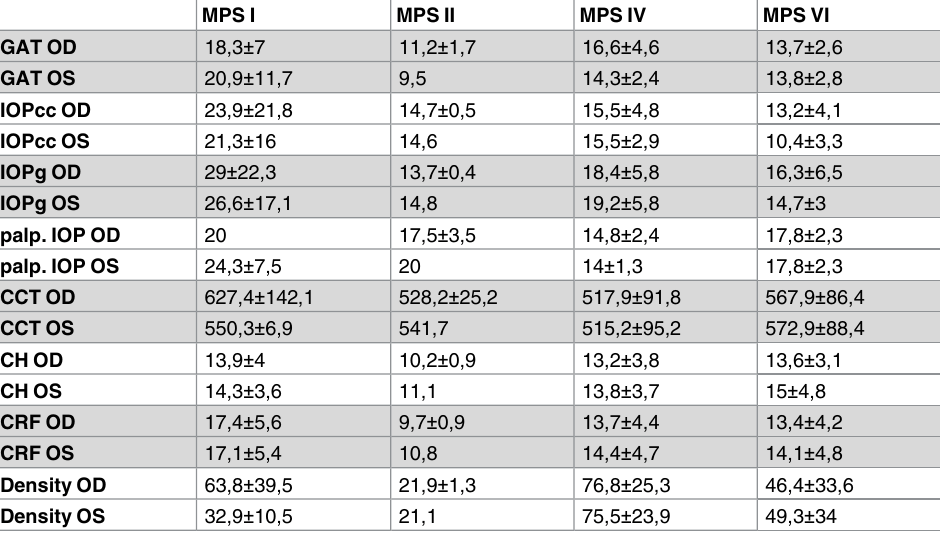
Table 6. Mean values, standard deviations (SD) and p-values of Goldmann applanation tonometry (GAT), corneal compensated intraocular pressure(ccIOP), Goldmann correlated intraocular